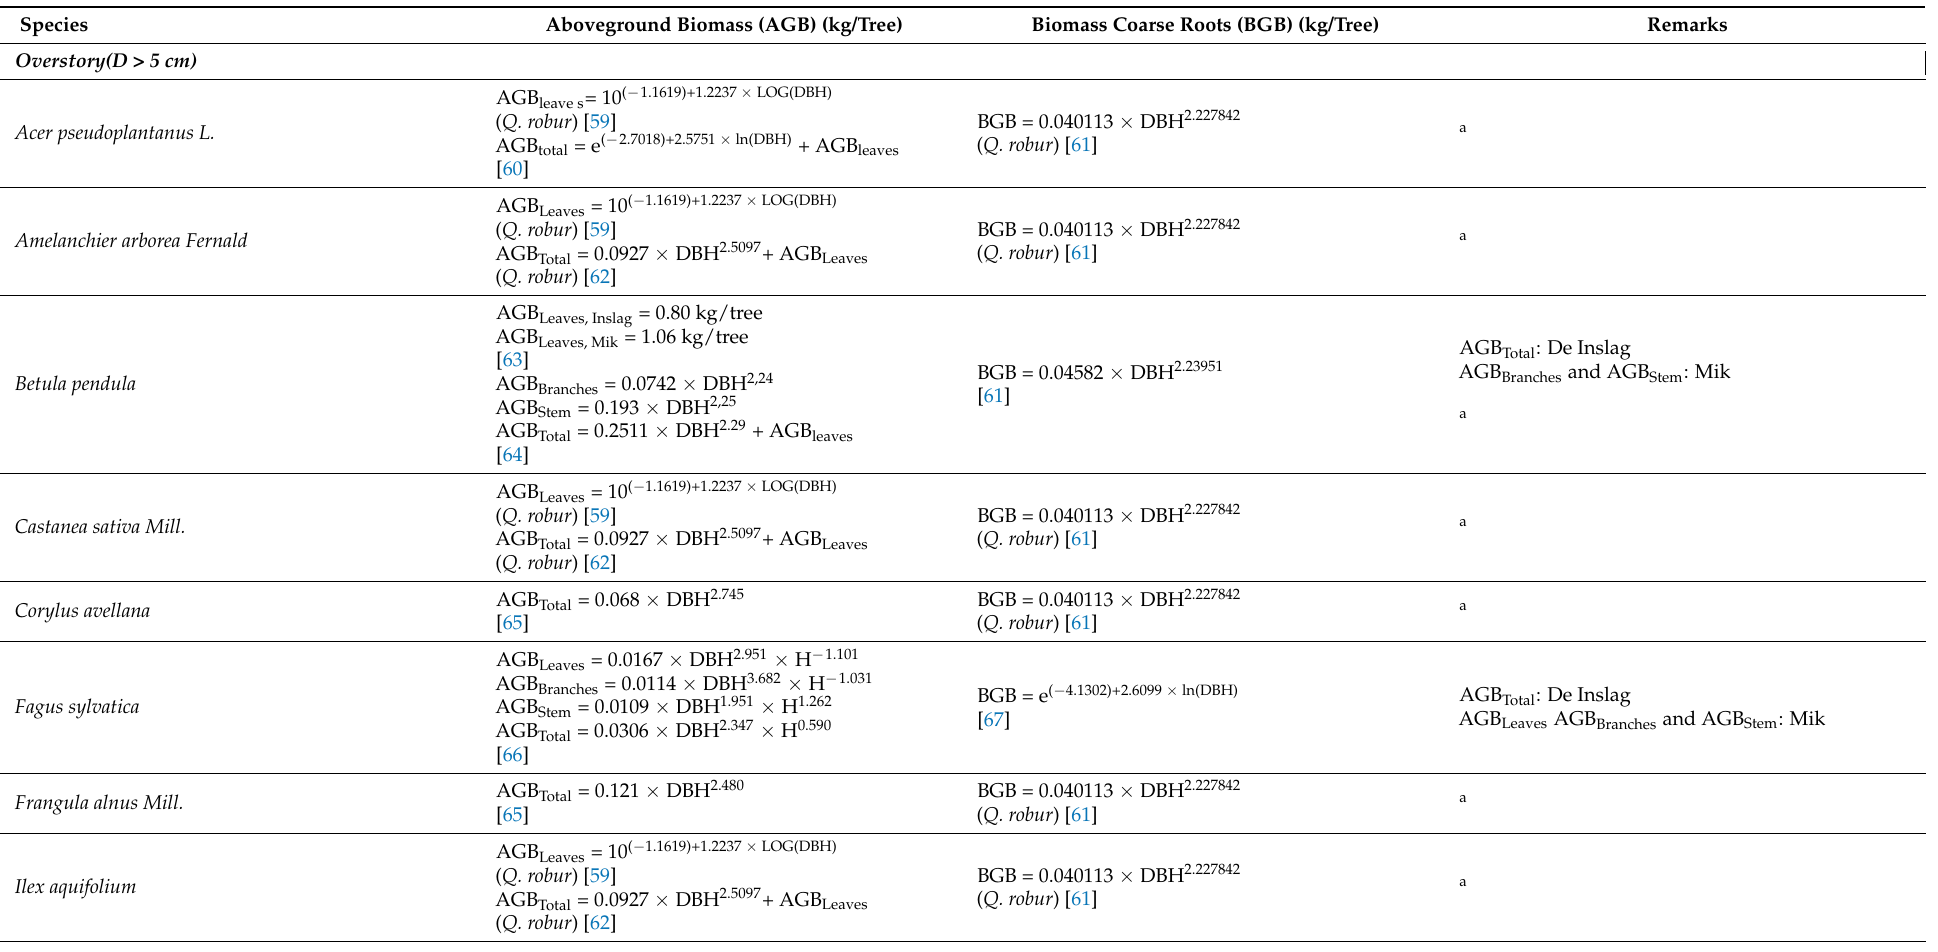
Table A1. Allometric relations used to calculate the aboveground biomass and biomass of the coarse roots of the overstory trees and understory trees. Species Aboveground Biomass (AGB) (kg/Tree) Biomass Coarse Roots (BGB) (kg/Tree) Remarks Overstory(D > 5